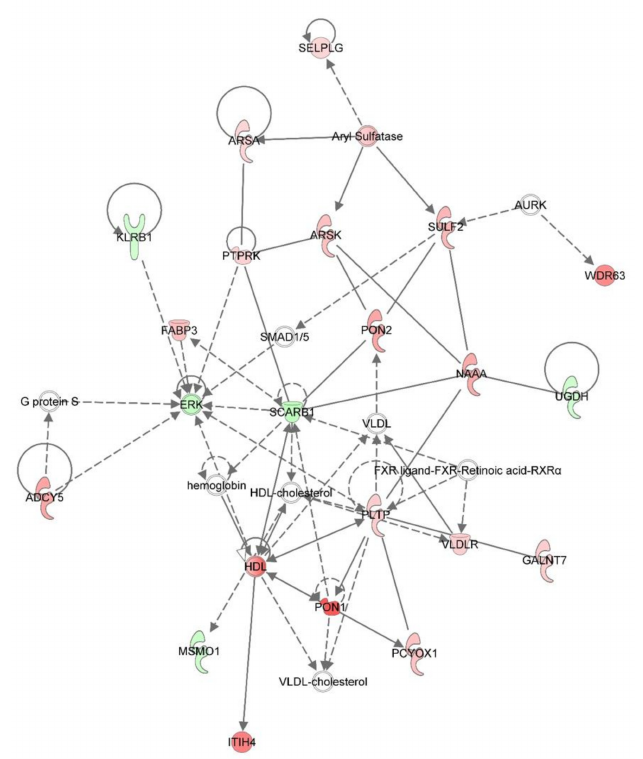
Figure 5. Changes in metabolic processes in PRRSV-infected alveolar macrophages. Red molecules are significantly upregulated in PRRSV-infected macrophages relative to mock-infected cells and green molecules are downregulated in at least one time point (12, 24, and 48 hpi). White molecules were not significantly ( p > 0.05) di ff erent between the two groups.